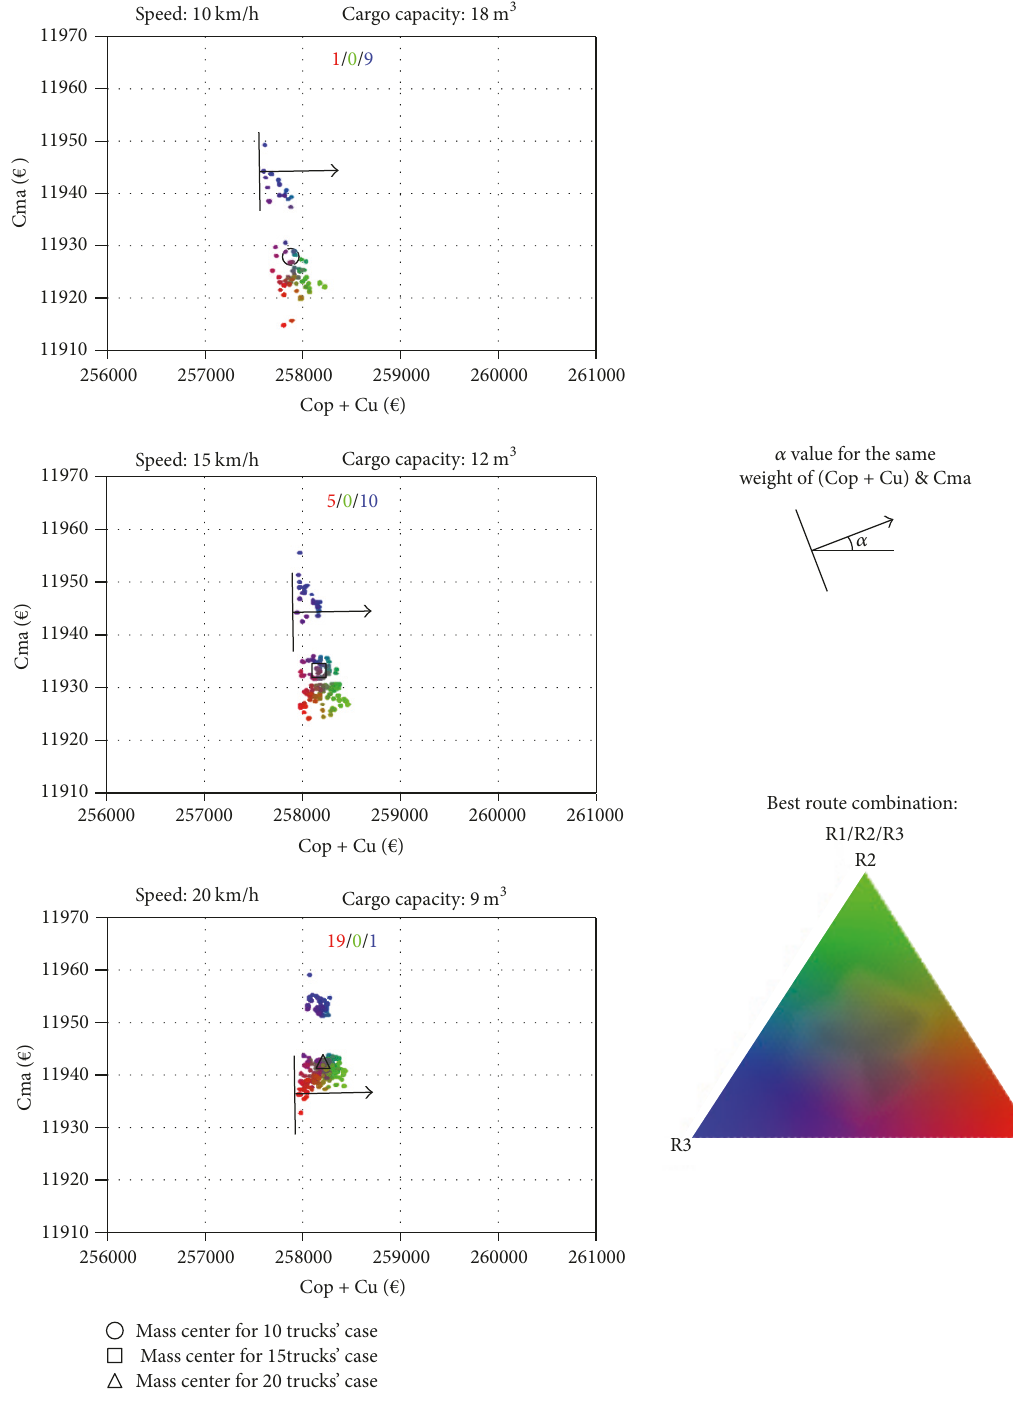
Figure 5: Possible ways to transport the